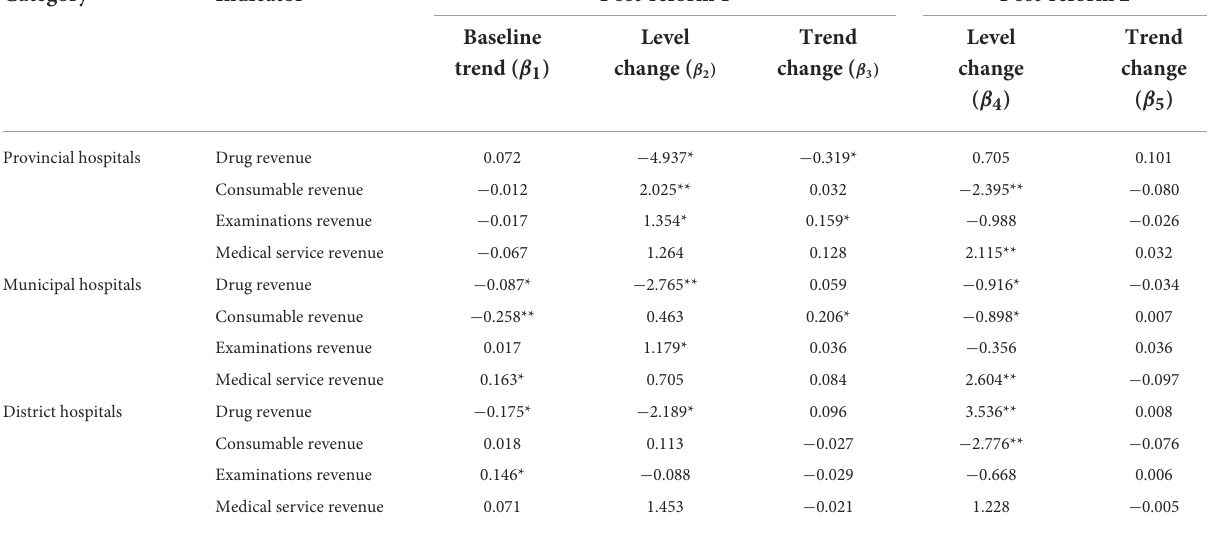
TABLE 2 Effects of reforms on hospitals’ revenue structures based on PITS models.